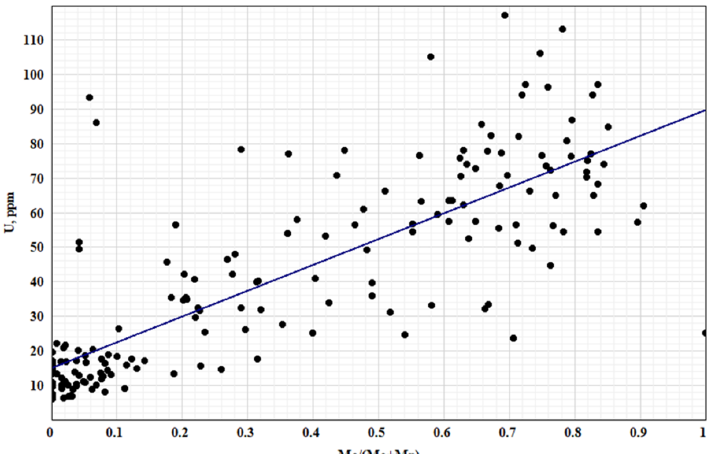
Figure 5. Cross ‐ plot of uranium concentration and Mo/(Mo + Mn) ratio for well 2, Bazhenov For ‐ Figure 5. Cross-plot of uranium concentration and Mo/(Mo + Mn) ratio for well 2, Bazhenov